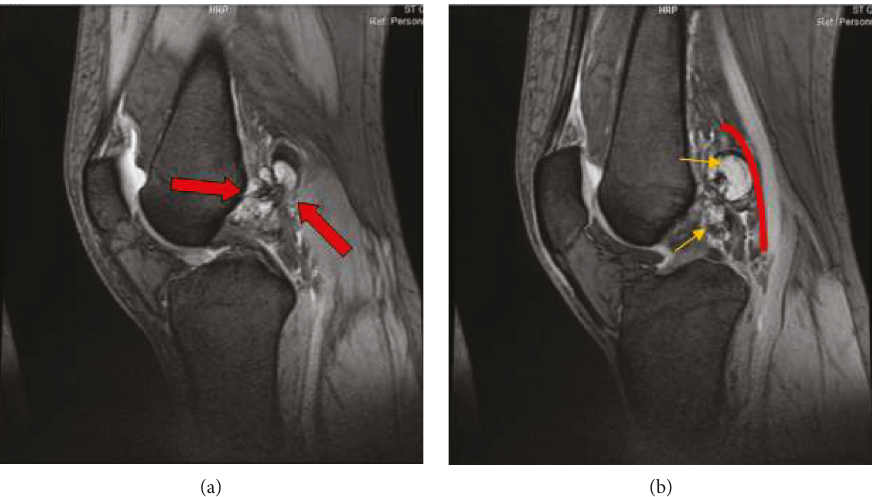
Figure 1: (a) Lateral-view T2 sequence MRI of the left knee showing a multiloculated structure arising from the synovium around the cruciate ligaments within the femoral notch. (b) The lesion is extending beyond the joint capsule posteriorly displacing the popliteal